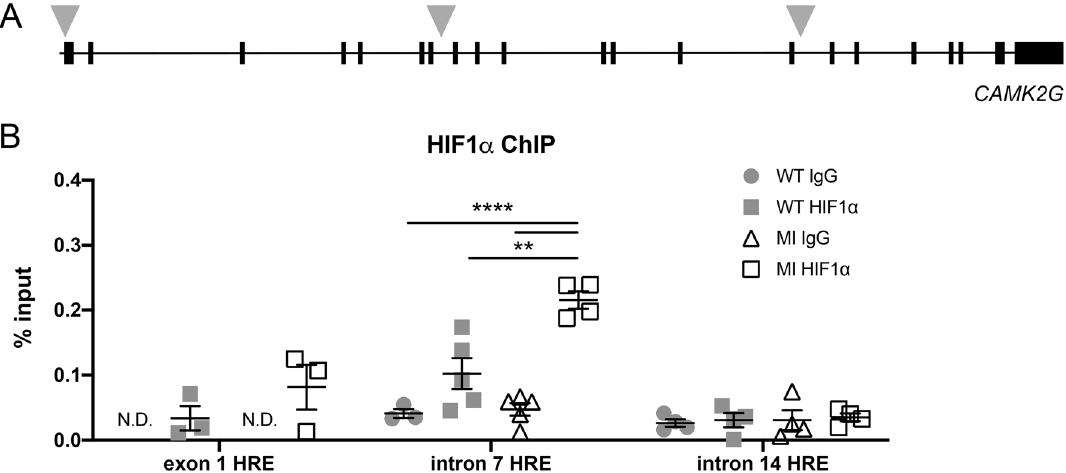
Figure 7. ChIP analysis of HIF1 binding to CAMK2G . ( A ) Schematic of CAMK2G . Gray arrows indicate potential HIF1 binding sites containing hypoxia response elements (HREs). ( B ) Semi-quantitative PCR analysis of HIF1α enrichment in naïve wild type (WT) and ischemic heart tissue 1 day after MI (MI) by ChIP. HIF1α showed increased binding compared to both WT and IgG controls at the intron 7 HRE. n = 3–5 for each group. Data shown as % input DNA with mean ± SD. Overall p -values were p = 0.52, p < 0.0001 and p = 0.95, for exon 1 HRE, intron 7 HRE and exon 14 HRE, respectively, using one-way ANOVA with Tukey’s multiple comparisons. ** p < 0.01, **** p < 0.0001 for between group comparisons. N.D. = not